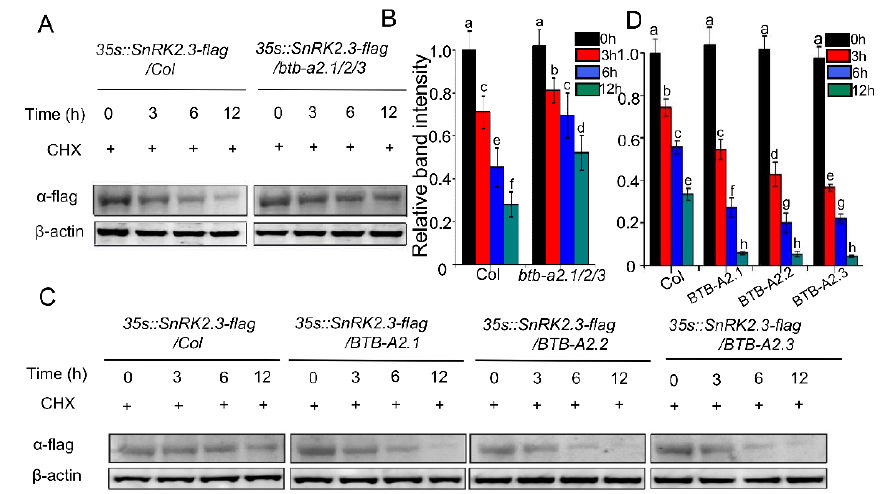
Figure 6. Arabidopsis BTB-A2s affect the stability of SnRK2.3. ( A , C ) The content of SnRK2.3 in WT, triple mutant btb-a2.1/2/3 plants, and BTB-A2s -OE plants was detected. Seven-old-day WT, triple mutant btb-a2.1/2/3 , and BTB-A2s -OE seedlings were subjected to 50 μM CHX (a protein synthesis inhibitor), and total plant proteins were extracted at specified time points. The protein level of SnRK2.3 was detected by monoclonal anti-flag antibody. Monoclonal β-actin antibody was used to normalize the loadings; ( B , D ) Quantitative analysis of the relative strength of bands based on Image J. Values labeled with different letters indicate a significant difference ( p < 0.05).